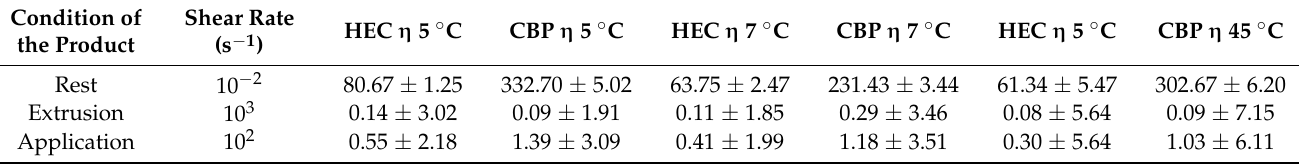
Table 4. Shear rate ramp test’s results (Pa × s) obtained for the formulation with hydroxyethylcel- lulose (HEC) and for the formulation with carbopol (CBP) at temperatures of 25, 37, and 45 ◦ C and at different shear rates to simulate different conditions. The results are presented as averages and relative standard deviation percentages